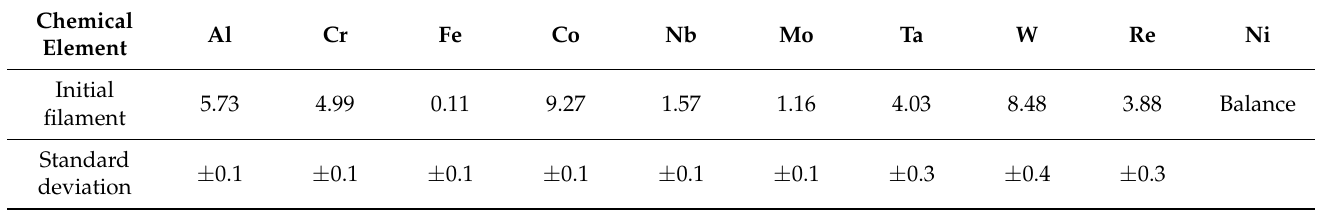
Table 1. Chemical composition (% wt.) of material in the initial filament (in the form of bars) from nickel-based superalloy ZhS32.